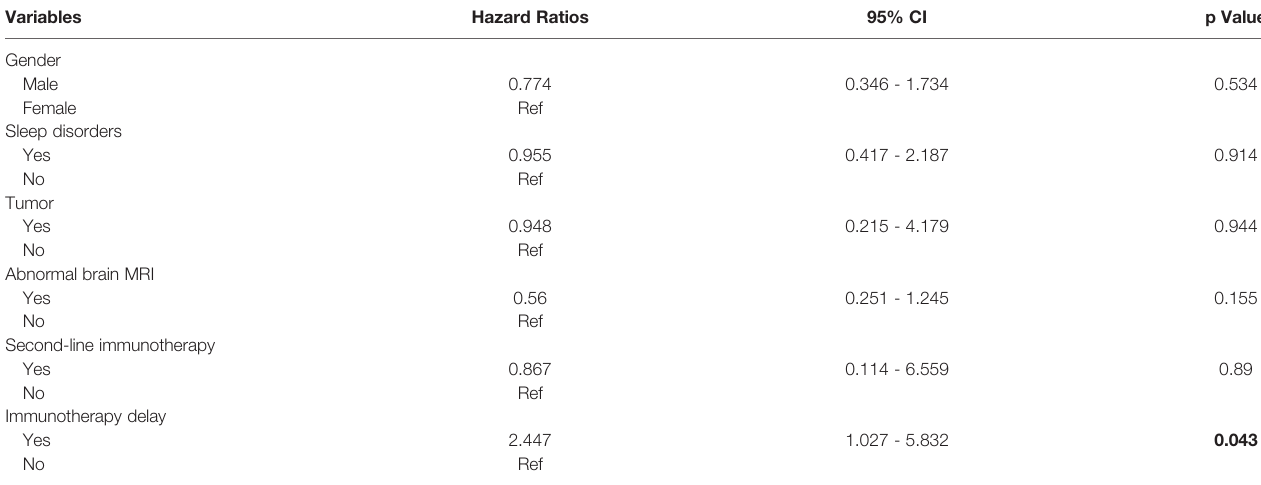
TABLE 2 | Multivariable analysis of predictors of clinical relapse. Variables